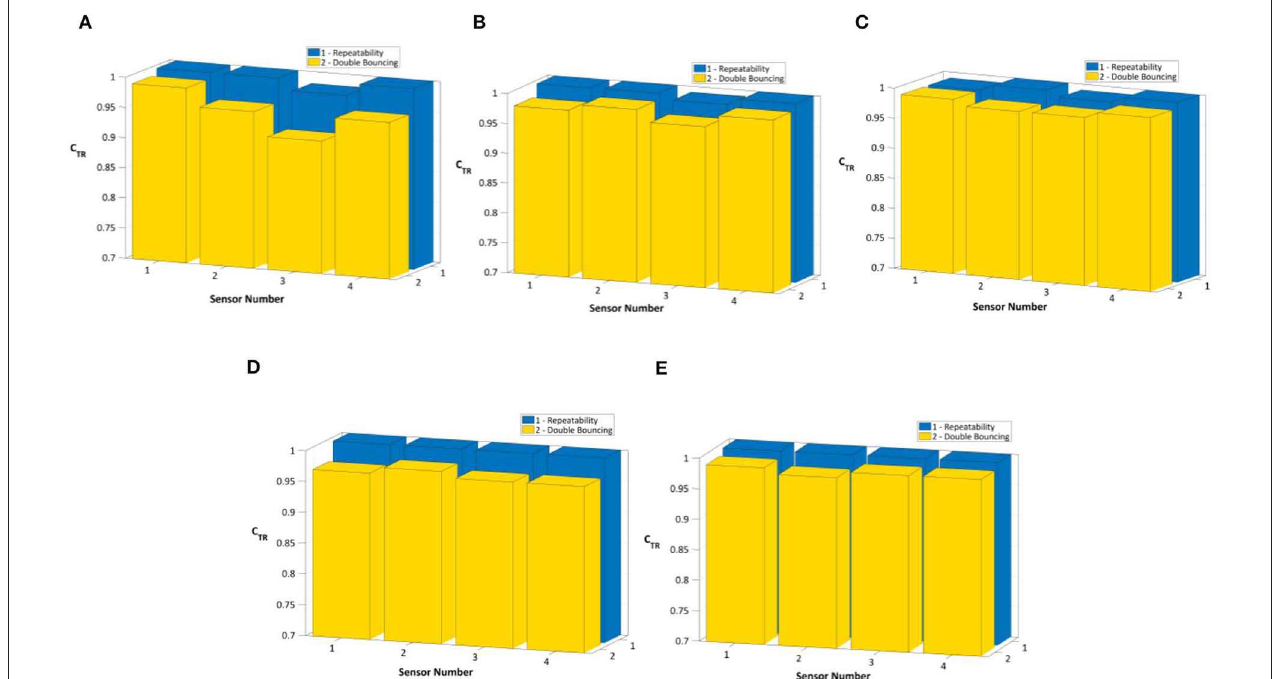
FIGURE 8 | Repeatability test and double bouncing test for impact point 1 (A) , 2 (B) , 3 (C) , 4 (D) , and 5 (E) .